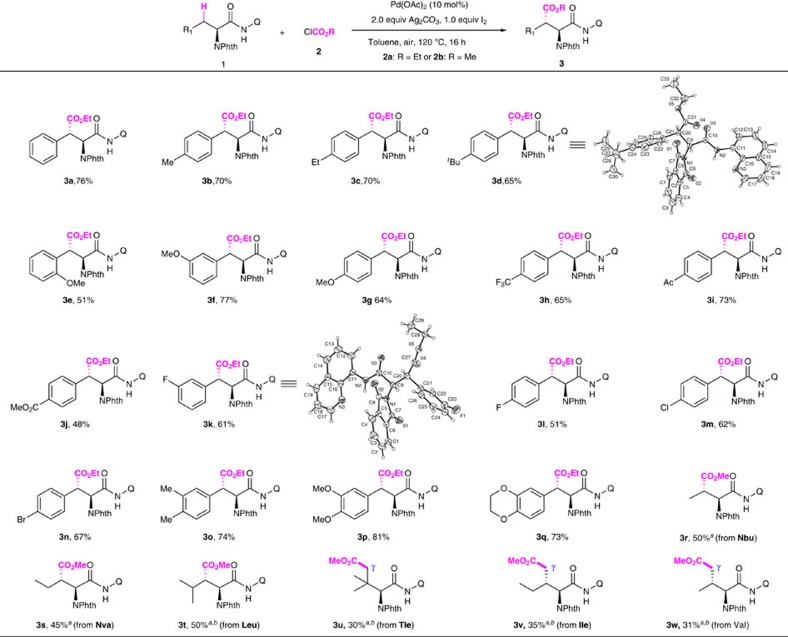
Pd-catalyzed alkoxycarbonylation of β-methylene C(sp3)–H bonds and γ-methyl C(sp3)–H bonds.Reaction conditions: 1 (0.15 mmol), Pd(OAc)2 (10 mol%), Ag2CO3 (2.0 equiv.), I2 (1.0 equiv.), ClCO2R (3.0 equiv.), toluene (2.0 ml), 120 °C, air, 16 h. Isolated yield. a20 mol% succinc anhydride was used. b140 °C.